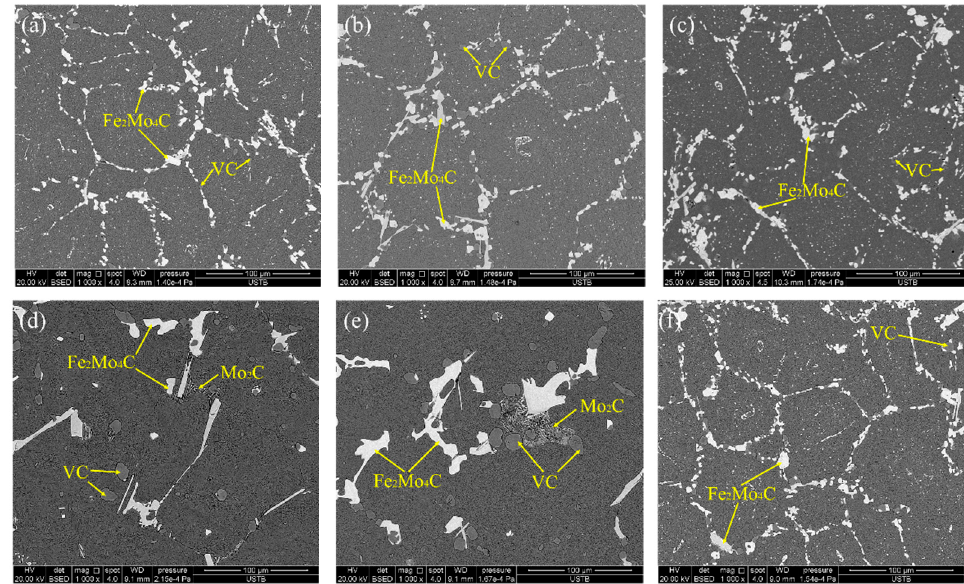
Figure 11. Effect of solution treatment temperature and solution treatment time on microstructure and carbide evolution: ( a ) 1080-1; ( b ) 1080-2; ( c ) 1080-4; ( d ) 1130-1; ( e ) 1130-2; ( f )